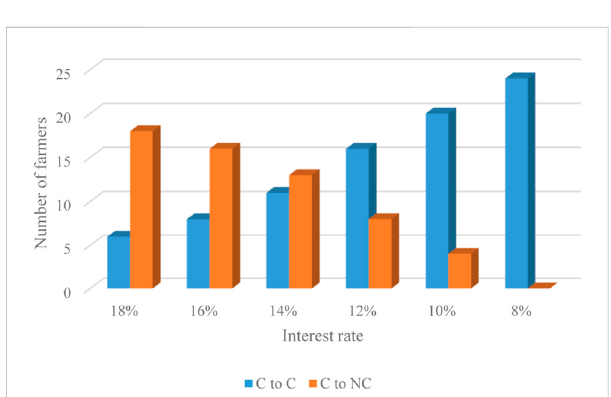
FIGURE 7 Analysis of the behavior of cooperative farmers with S1 and S2 policies. (C to C: Continue cooperative behavior and C to NC: Changing from cooperative to non-cooperative behavior).